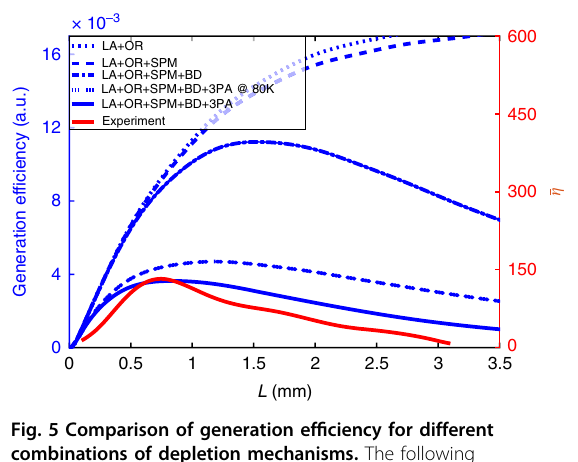
Fig. 5 Comparison of generation ef fi ciency for different combinations of depletion mechanisms. The following mechanisms were considered: linear absorption (LA), optical recti fi cation (OR), self-phase modulation (SPM), pump beam divergence (BD), and 3-photon absorption (3PA). Simulated curves are plotted against the left axis, while the experimental integrated enhancement curve is plotted against the right axis. Data shown here are for sample II ( d = 50 μ m, θ bev ¼ 53 (cid:5)